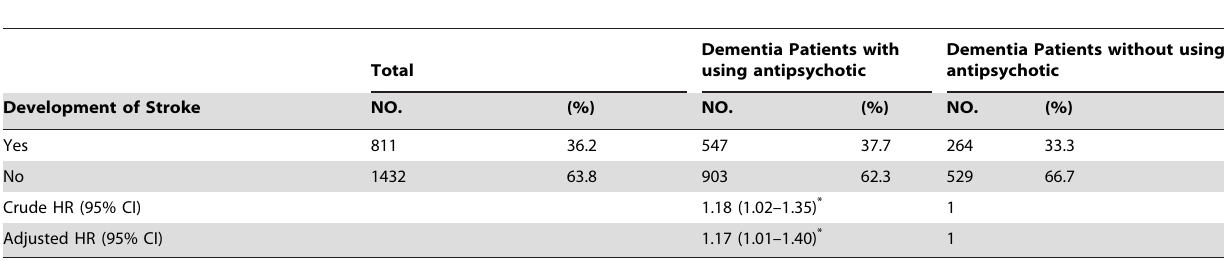
Total patients with dementia number=2243.Adjustments are made for age, sex, monthly income, geographic region, hypertension, diabetes. *Indicates p ,